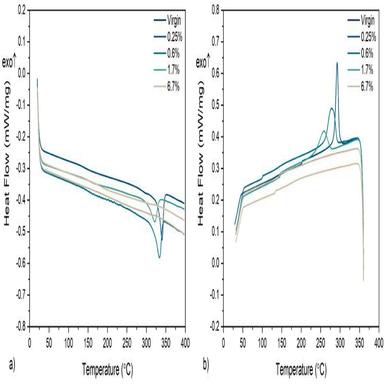
DSC thermograms of a) the second heating cycle and b) the cooling cycle for the virgin CF-PEEK and the CF-PEEK samples that have lost 0.25%, 0.6%, 1.7% and 6.7% of their initial mass (heating rate: 50 ◦C/min).